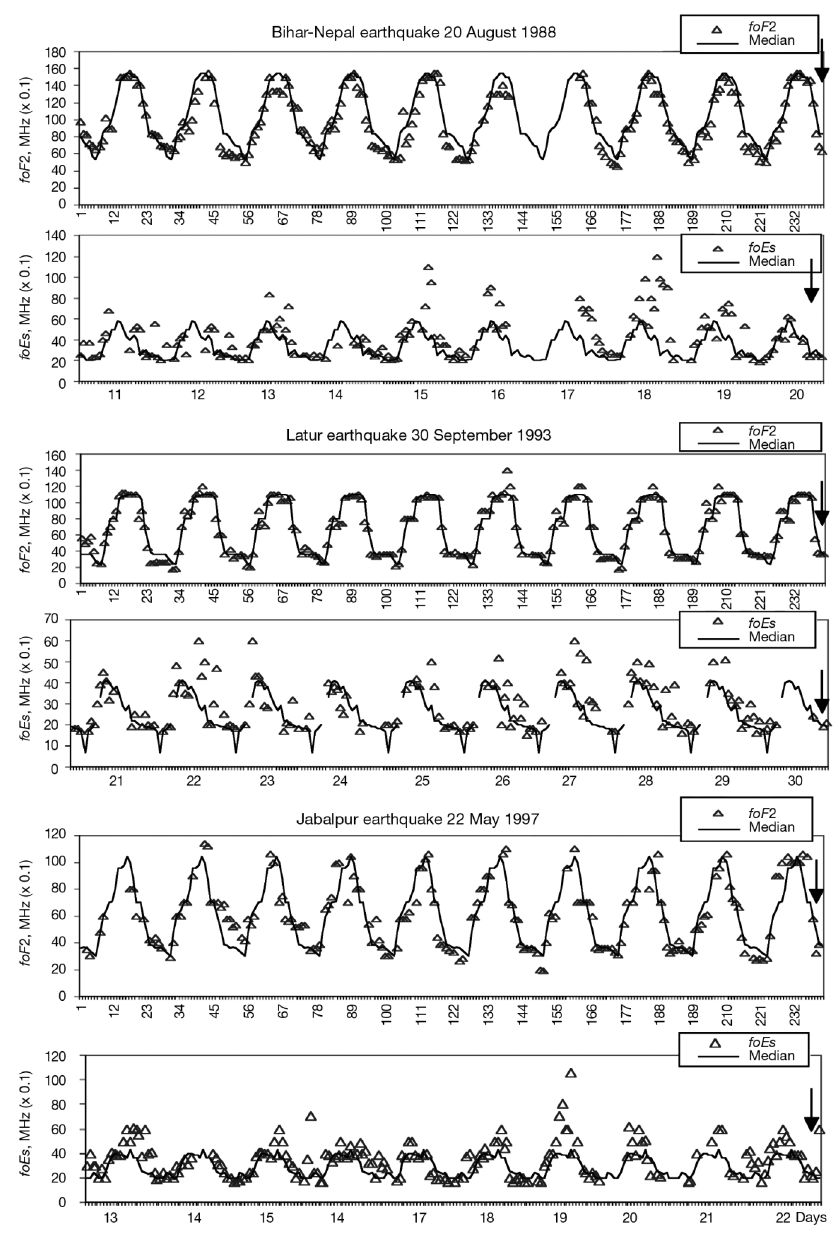
Fig. 2a. The variations of monthly median of foF 2 and foEs (shown by solid curves) and hourly measured val- ues (shown by open triangles) for ten days before the occurrence of the earthquakes in the months of August, 1988 (top two panels), September, 1993 (middle two panels) and May, 1997 (bottom two panels). Monthly me- dian is repeated on each day. The inverted arrows indicate the days of the